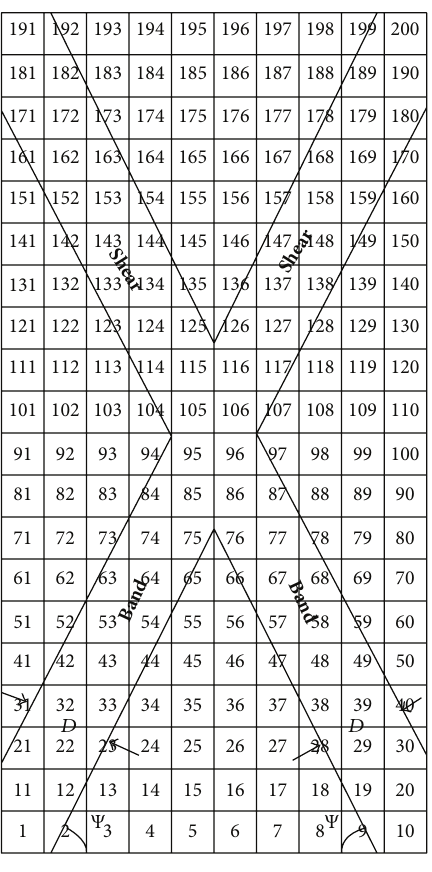
D: thickness of shear bands Ψ: inclination angle of shear bands Figure 8: Schematic diagram of shear bands.